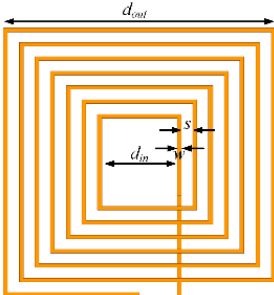
Figure 2. Geometric design parameters of the square coils.